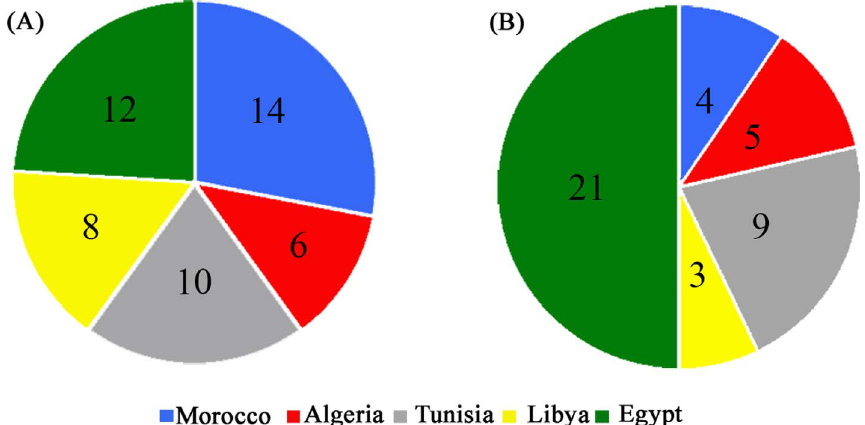
Figure 9. Overall number of studies dealing with human and animal toxoplasmosis in fi ve North African countries (Morocco, Algeria, Tunisia, Libya and